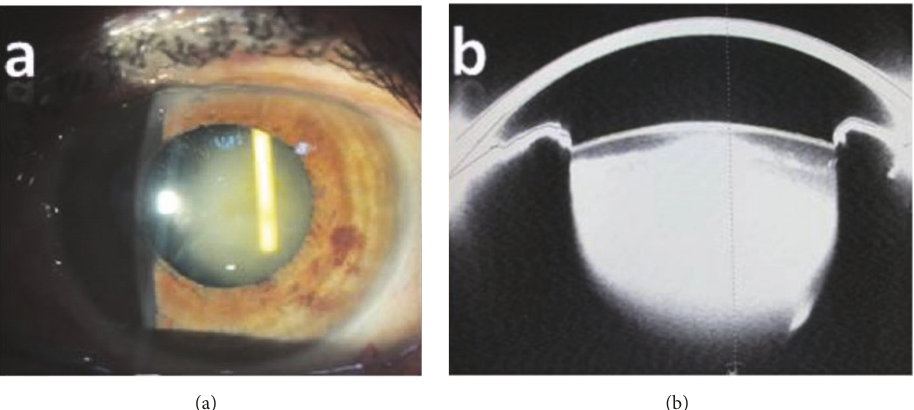
Figure 1: (a) Slit lamp photograph showing the intralenticular Ozurdex implant. (b) Scheimpflug image showing the intralenticular Ozurdex implant together with the intact posterior capsule.